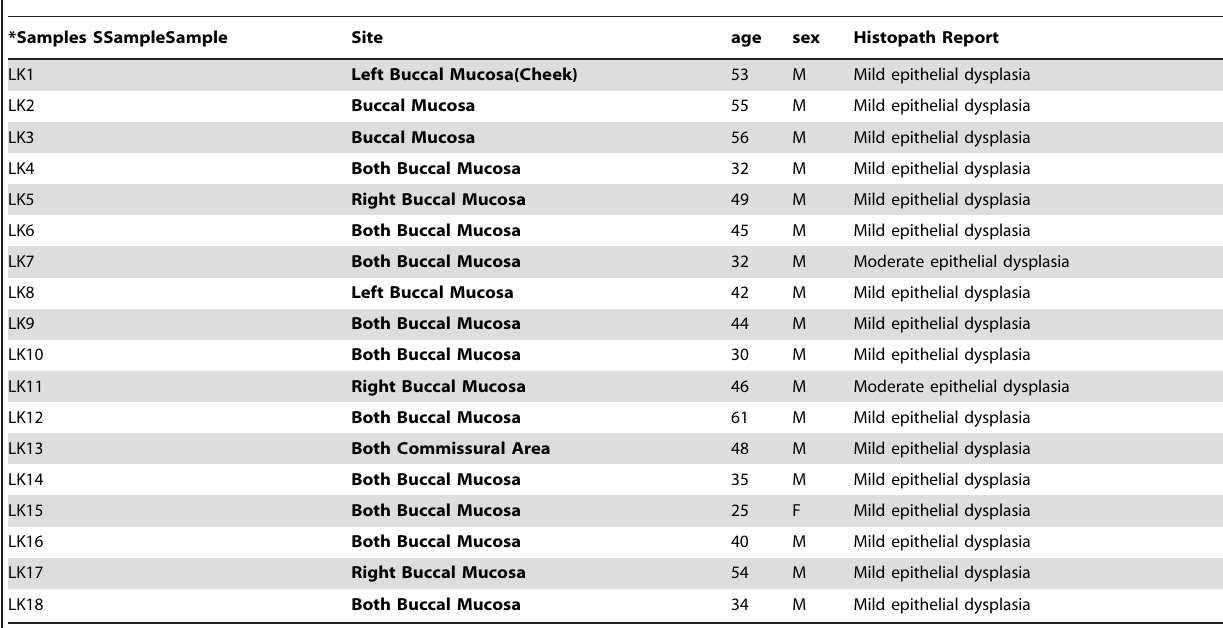
Table 3. Demography of 18 leukoplakia patients.